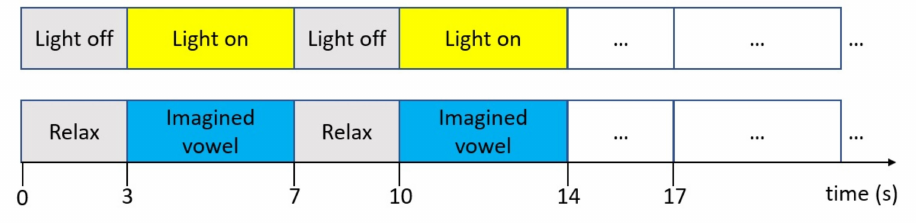
Figure 2. Time intervals for the imagined vowels experiment. When the light is on, the subject imagines the vowel and when the light is off, the subject